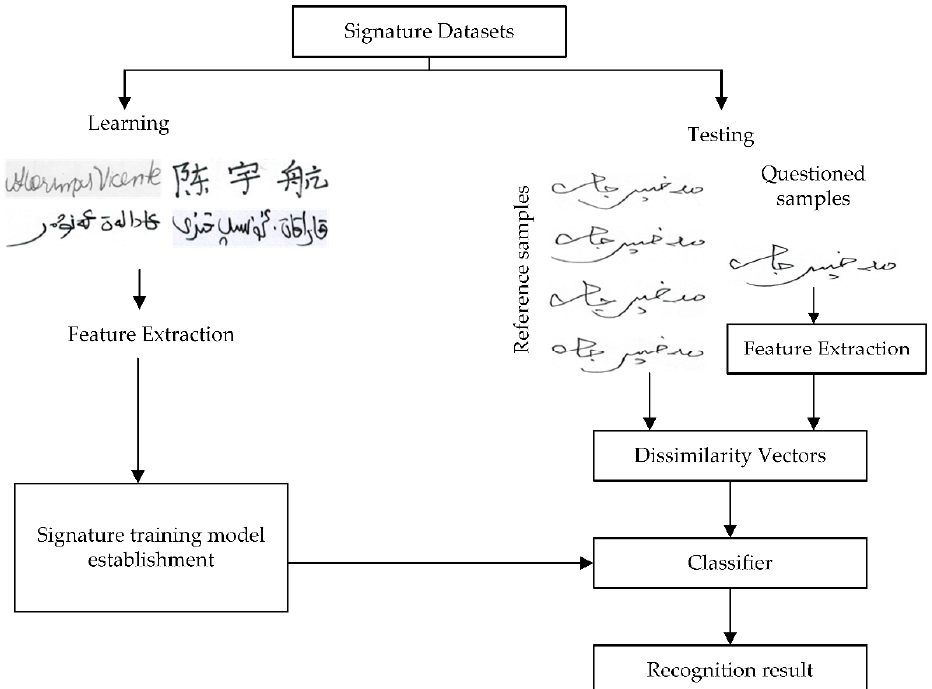
Figure 1. Offline signature authentication system model.